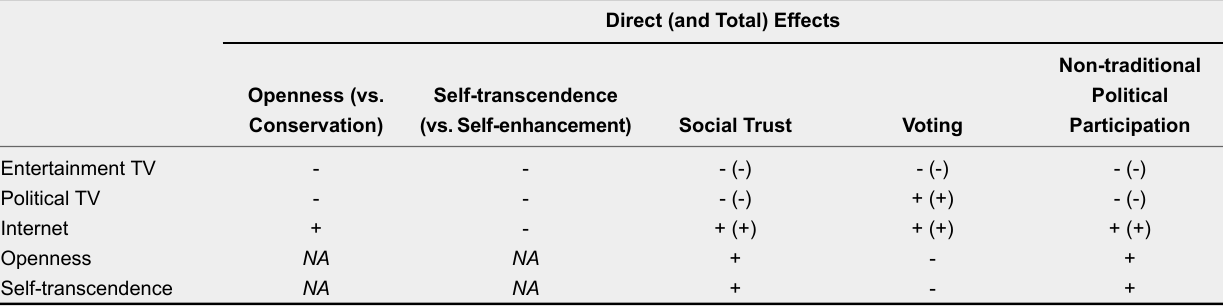
Hypothesized Direct and Total Relationships Between Media Use, Values and Civic Life